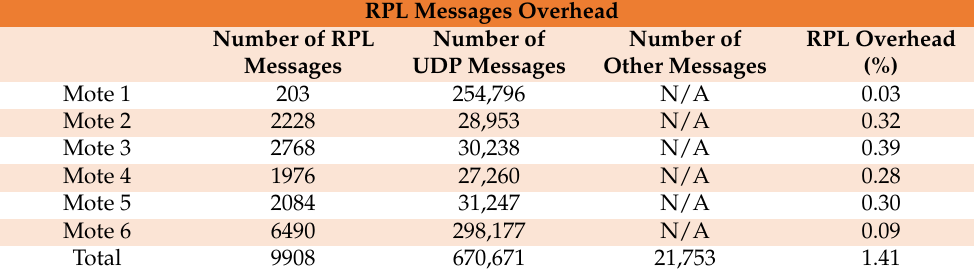
Table 4. RPL messages overhead of the IoT/IIoT network in the benign scenario.